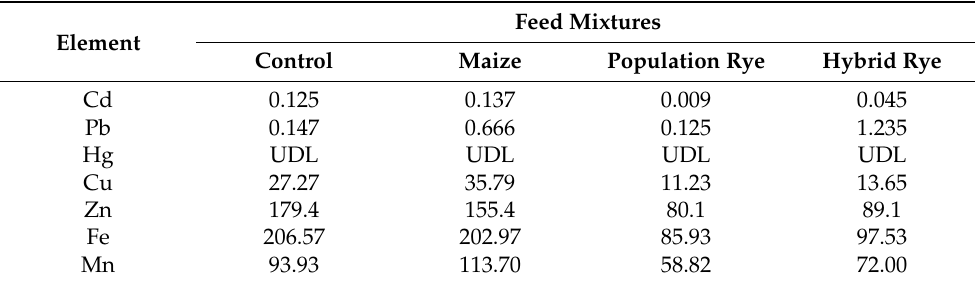
Table 5. The mean content of heavy metals (mg/kg) in finisher mixtures, on a dry matter basis (b. wt.), used in control and experimental feeding of